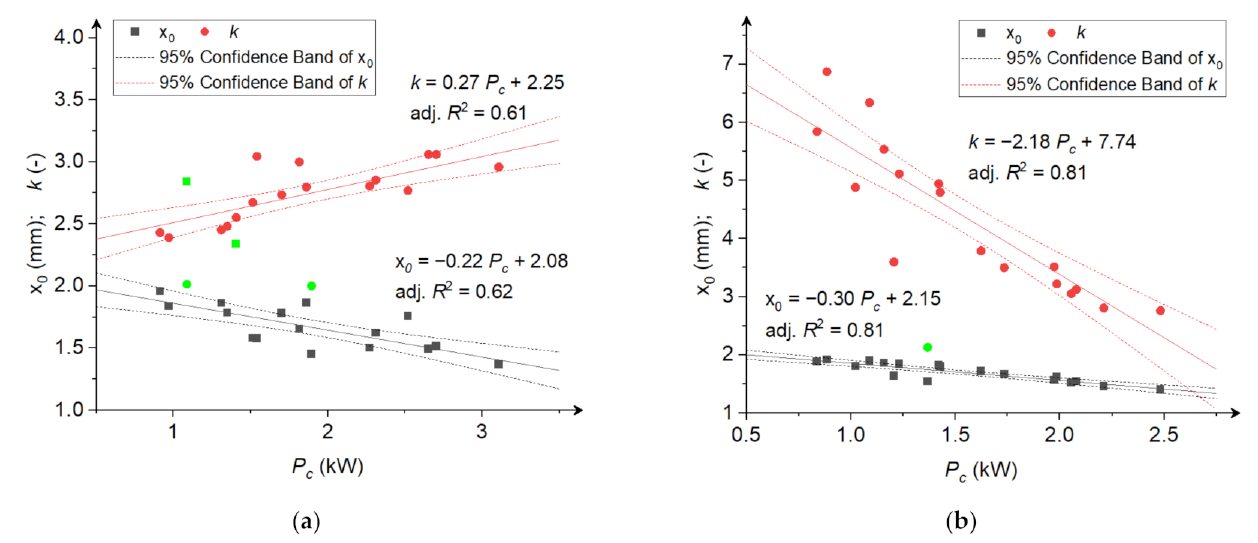
Figure 7. The dependence between RRSB distribution parameters and power consumption during comminution; ( a ) corn grains; ( b ) rice grains. The green points are outliers not included in the